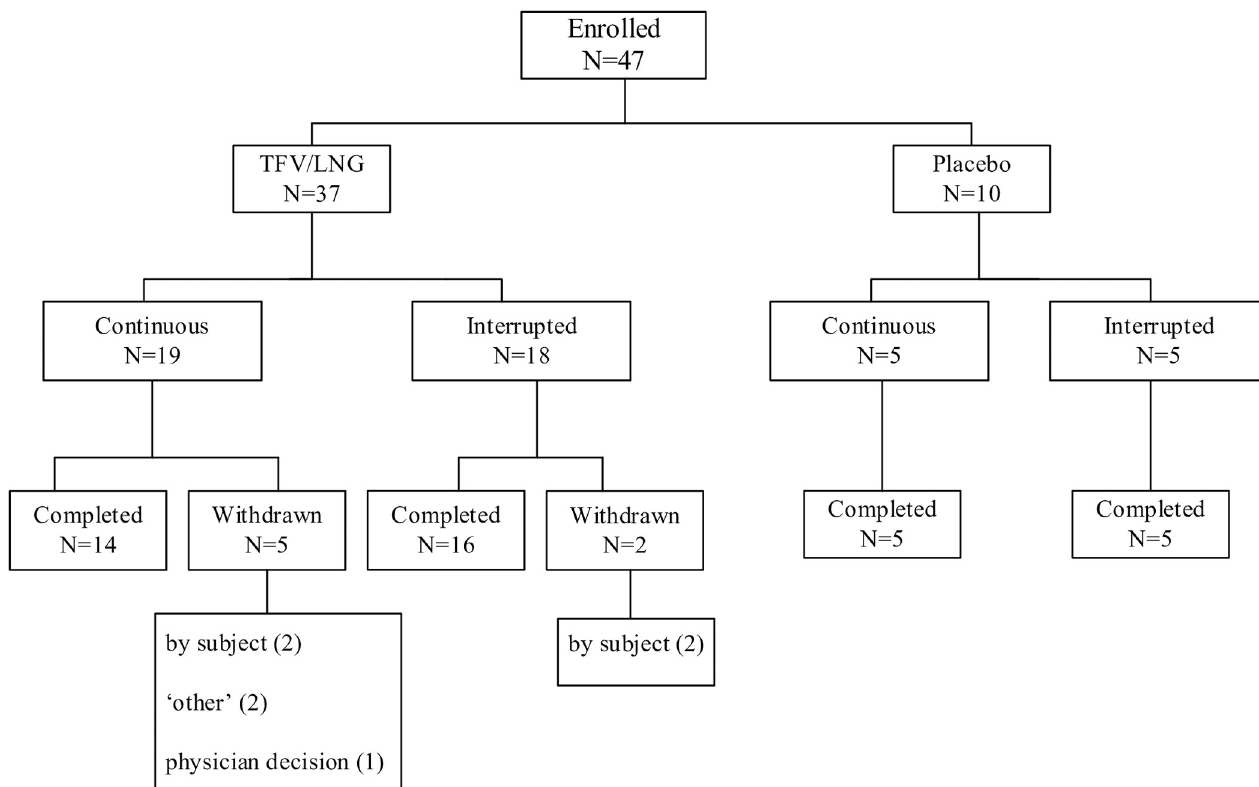
Fig 1. Disposition of